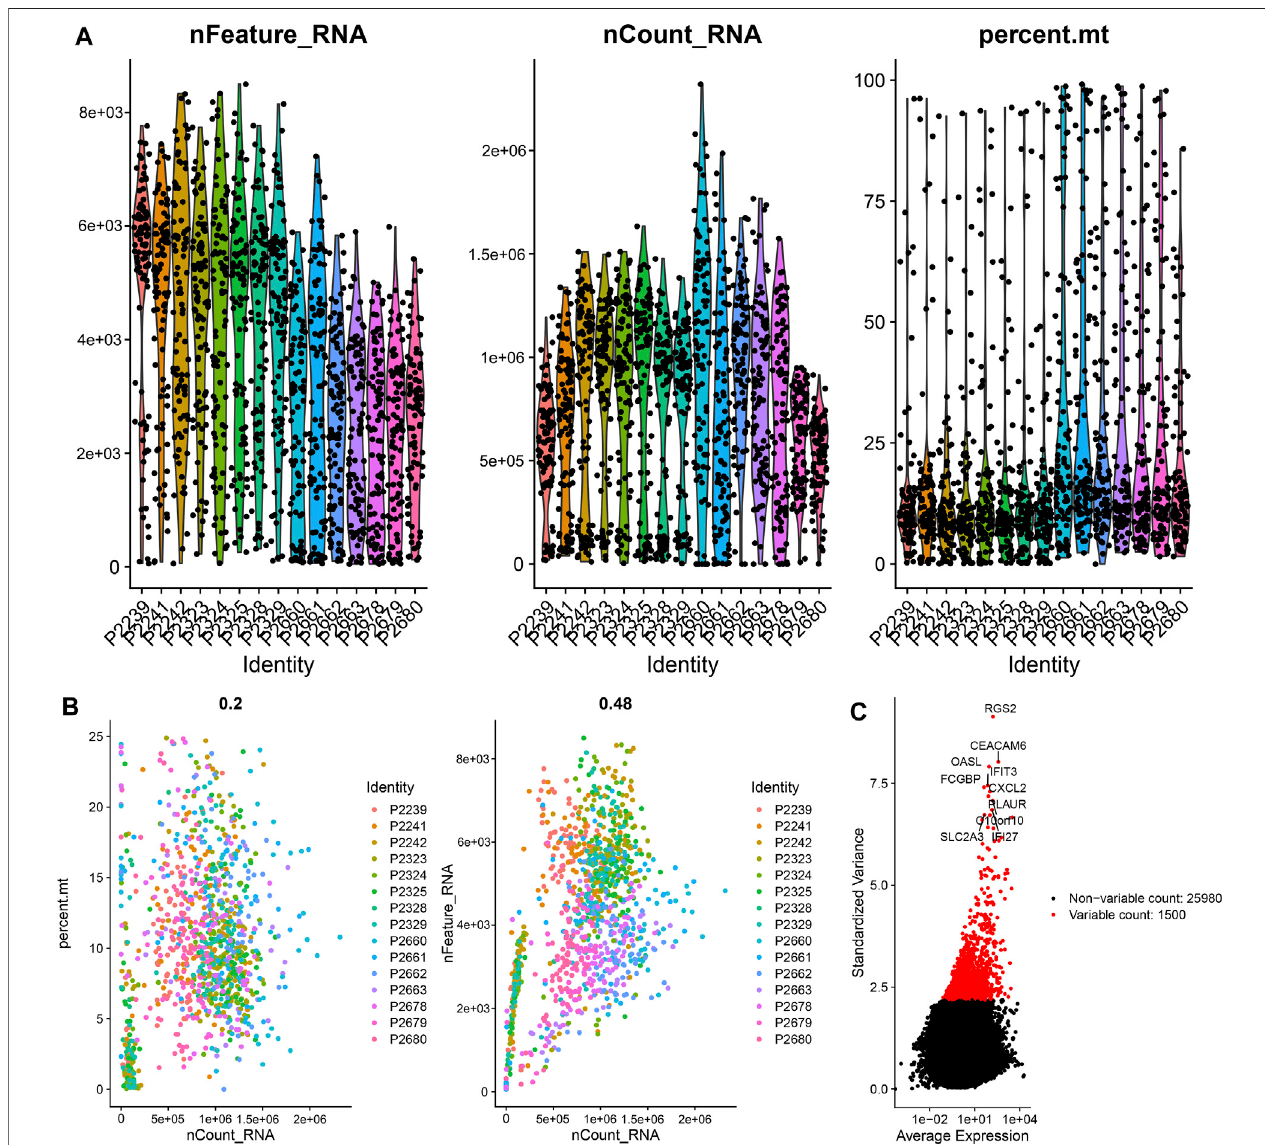
FIGURE 1 | Quality control and normalization of scRNA-seq data. (A) After quality control, 1,092 CC cells were selected for analysis. (B) Results of correlation analysis. (C) The variation of 27,480 genes between CC cells. scRNA, single-cell RNA sequencing; CC, colon cancer.